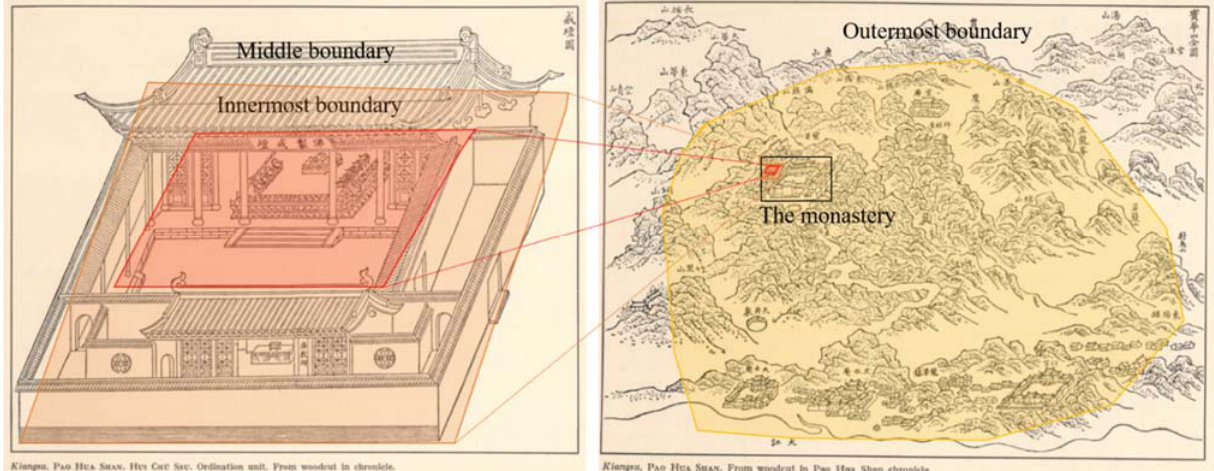
Figure 14. A diagram showing the three boundaries of the Monastery according to Jianyue’s sermon (drawing by author, base map: Figure 13 & BHSZ [1795] 1975, vol. 1, pp. 3, 6). (drawing by author, base map: Figure 13 & BHSZ [1795] 1975, vol. 1, pp. 3,